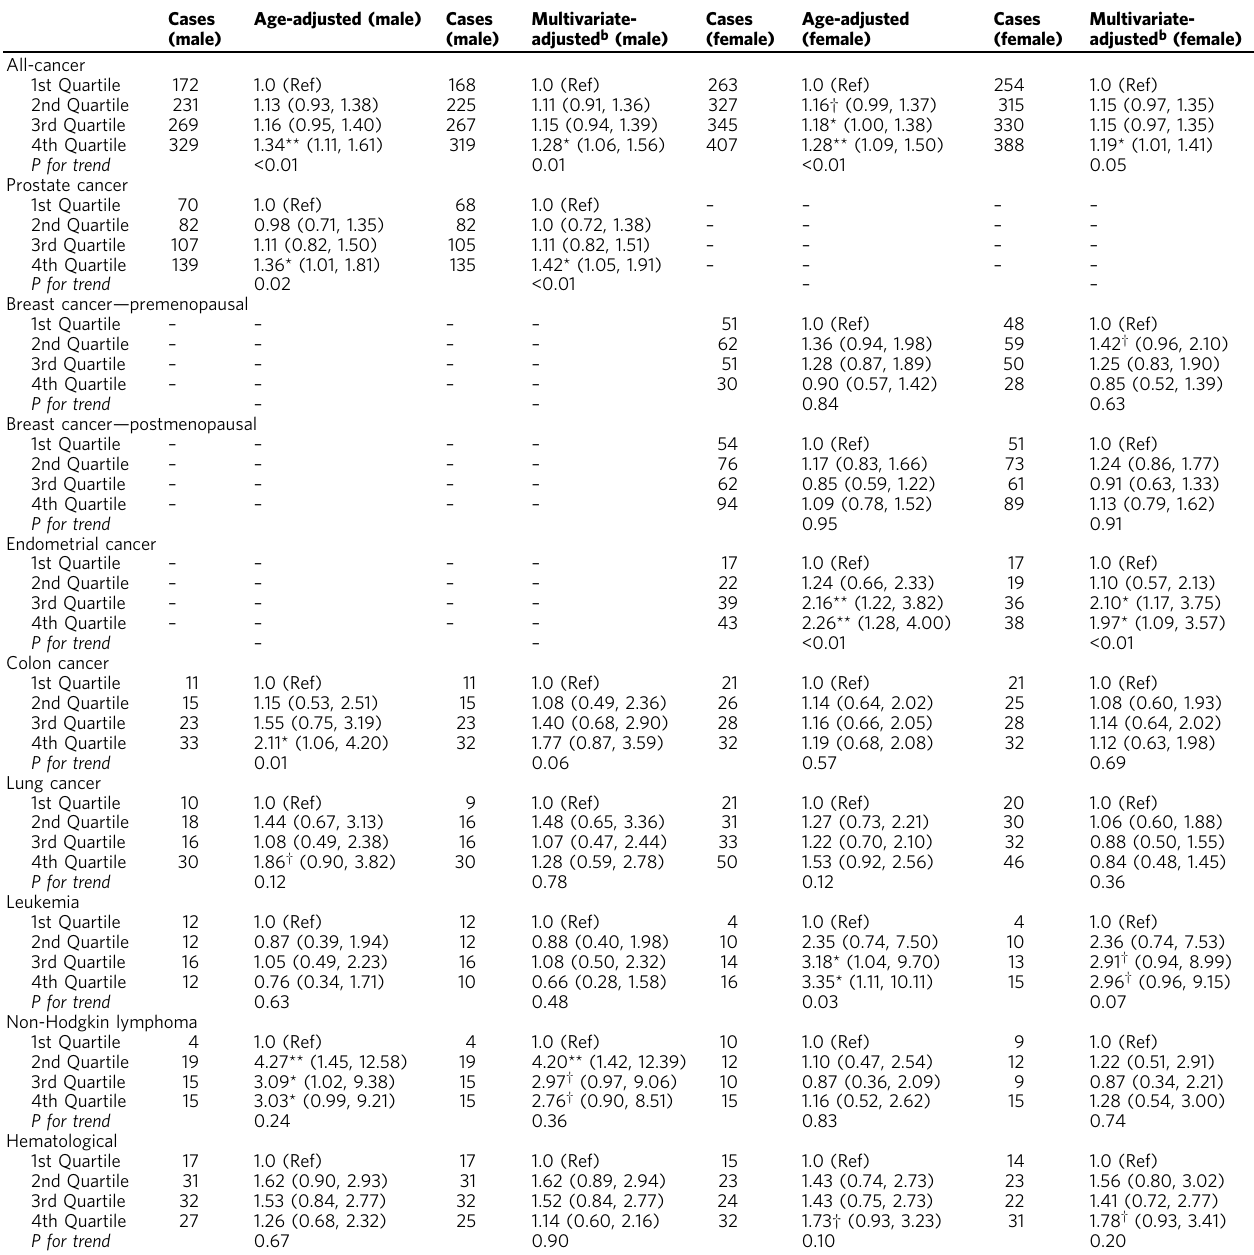
Table 4 Results from analyses of waist-to-hip ratio (quartiles) a and cancer incidence ( n = 26,342) Cases